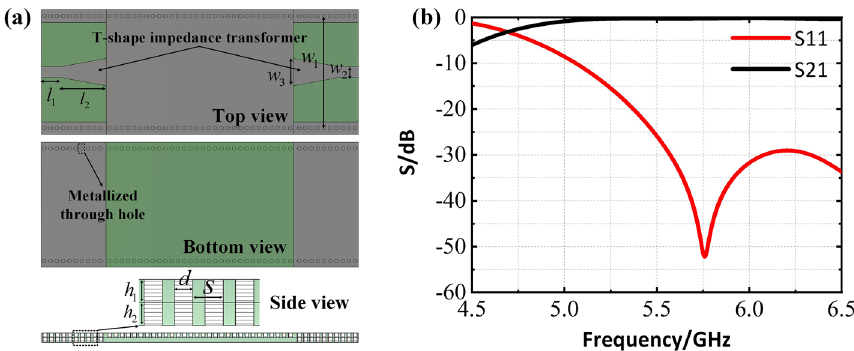
Figure 1. ( a ) Three views of the SIW structure. Some key parameters (length in mm) are: h 1 = 0.762 , h 2 = 0.762 , w 1 = 17.6 , w 2 = 1.7 , w 3 = 4.4 , l 1 = 2 , l 2 = 7 , s = 1, d = 0.3. ( b ) Scattering parameters of the SIW